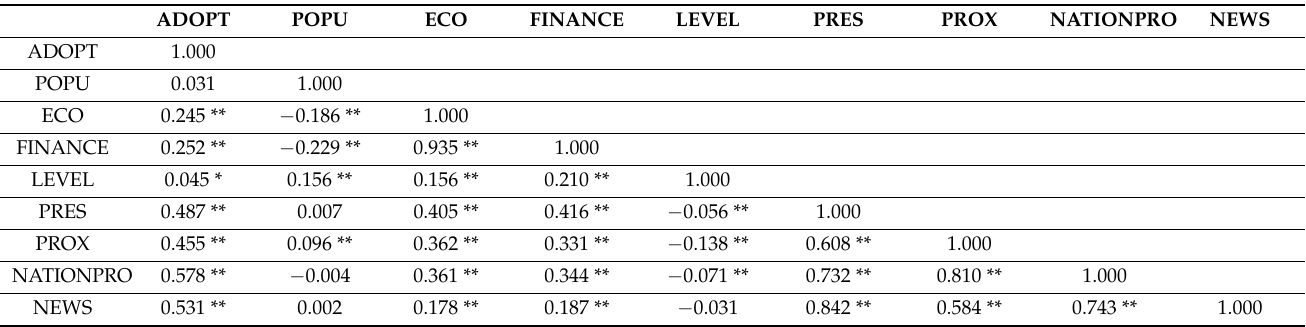
Table 3. Correlation